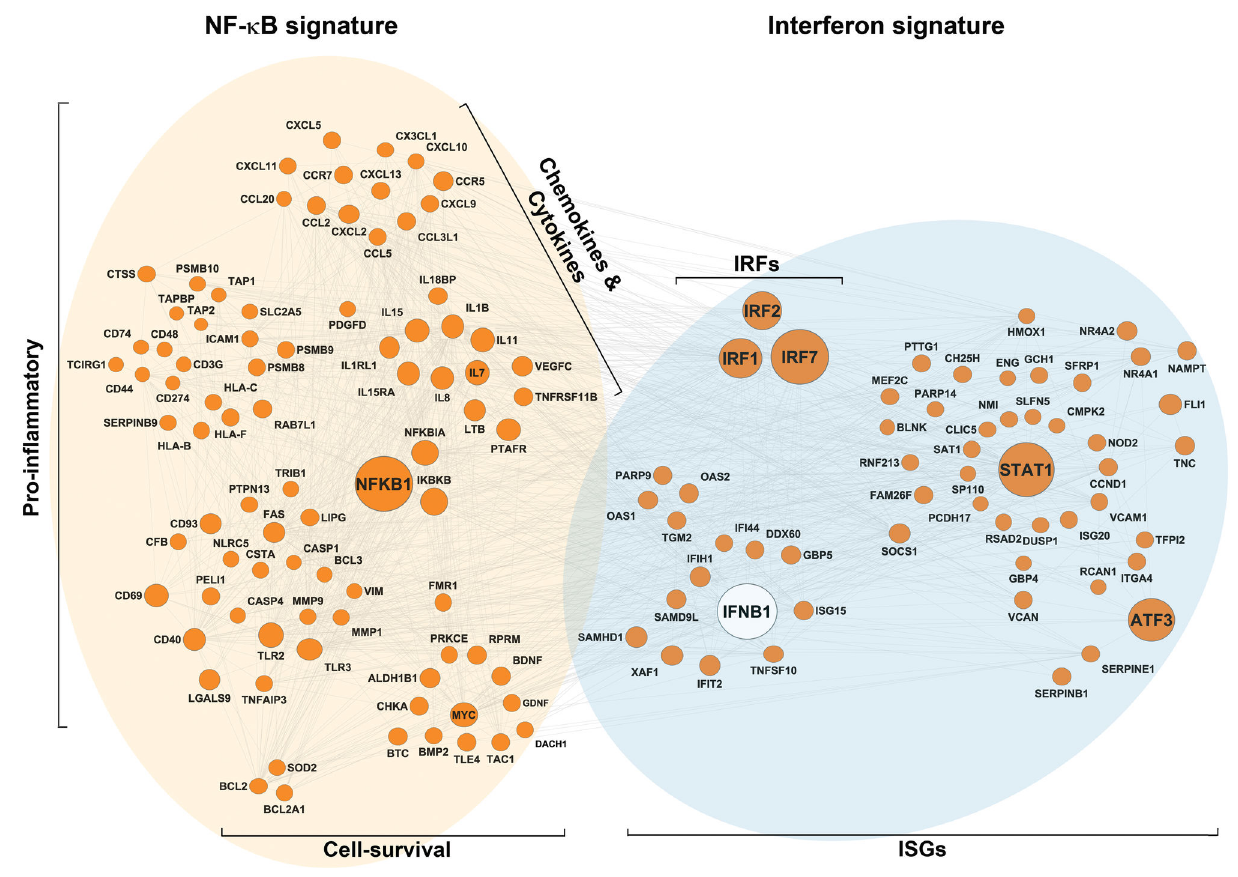
Figure 4. Molecular network of NF-κB and IFN signatures in ccRCC. The network was constructed by Ingenuity Pathway Analysis software (Ingenuity® Systems, HUhttp://www.ingenuity.comUH) using all genes in the NF-κB and IFN signatures. Key clusters in NF-κB (brown) and IFN (blue) arms are identified, and regulatory molecules controlling gene-network nodes are shown as large